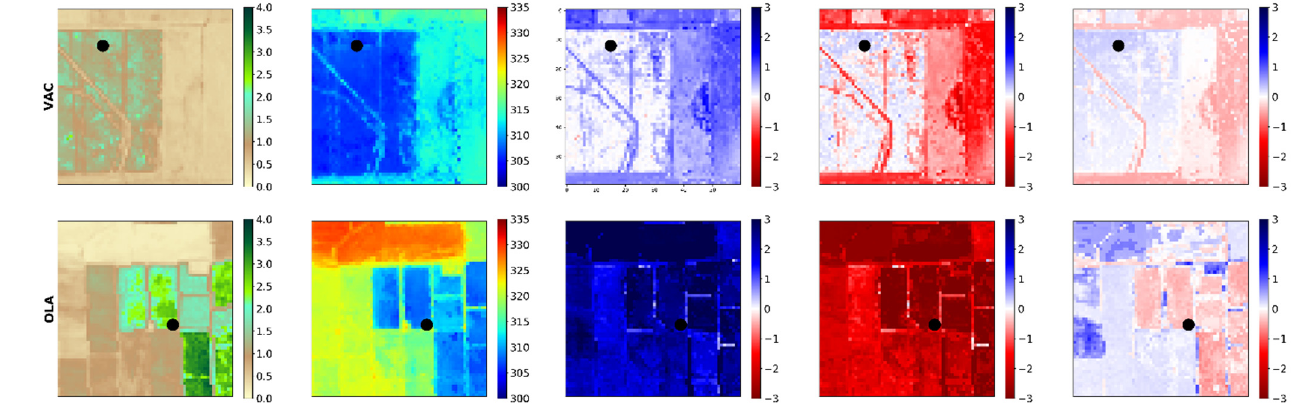
Figure 11. Spatial maps of LAI, LST, and the differences between DisALEXI-PT and DisALEXI-PM